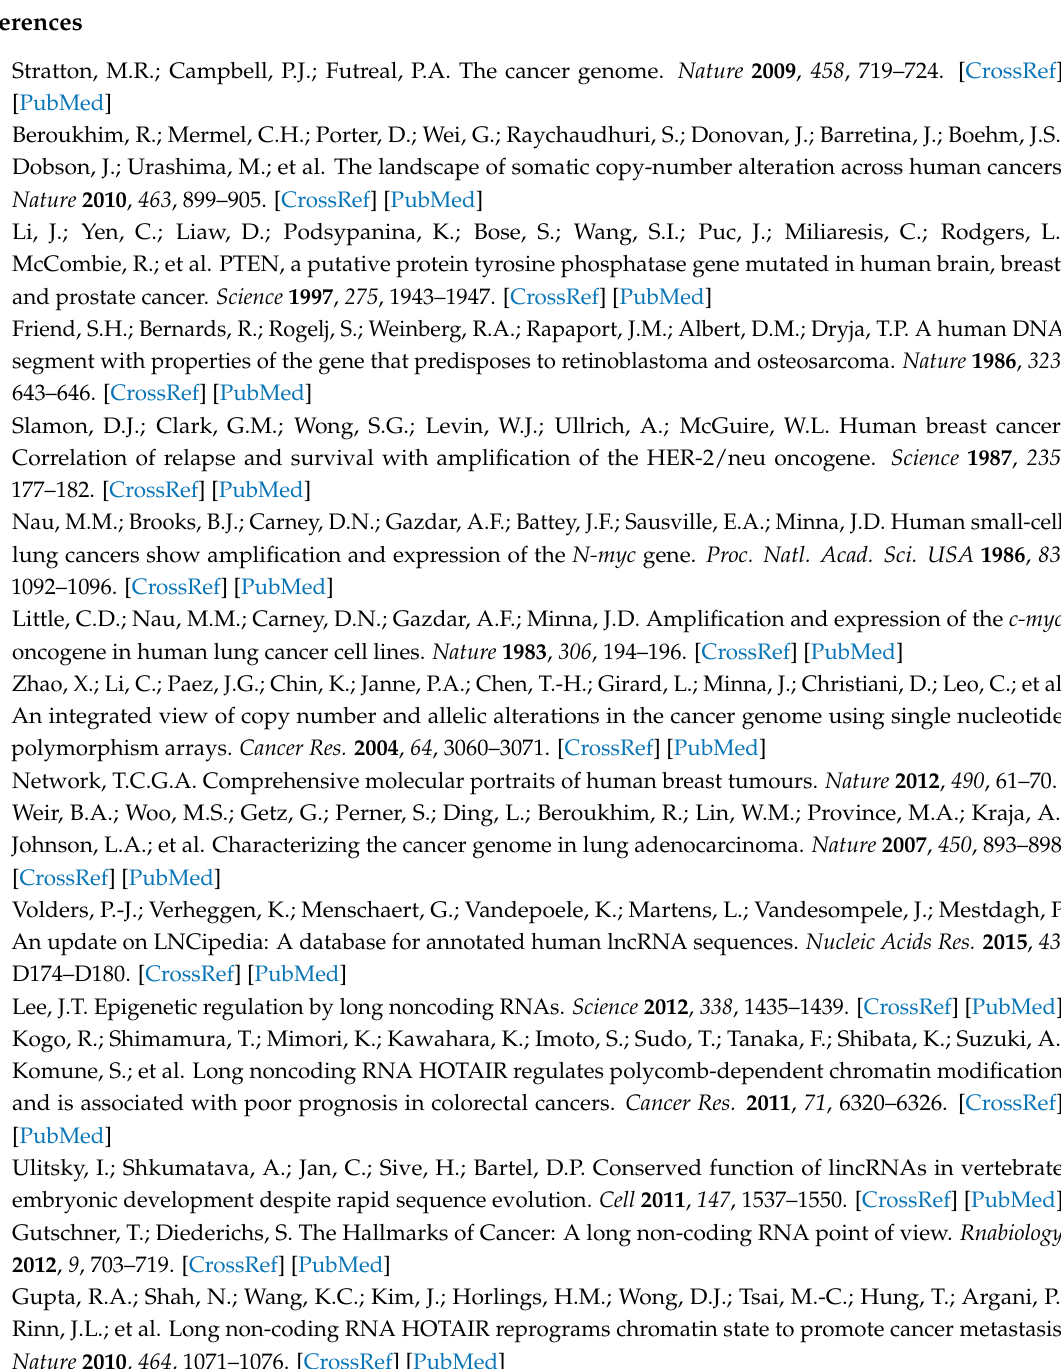
the tested cell lines; Table S2: Overview of the lncRNA genes affected by focal SCNAs and the copy number of the normal flanking protein-coding genes, and their copy number status in